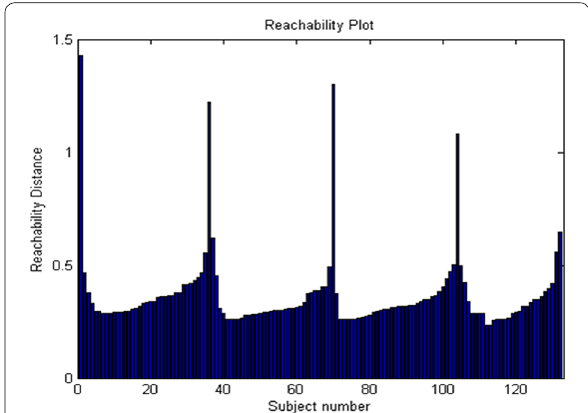
Fig. 1 Example illustration of the reachability plot obtained in